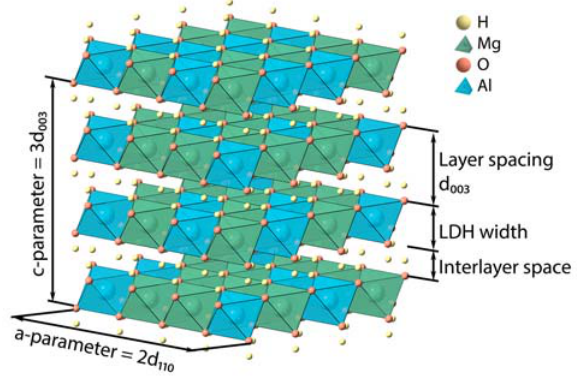
Figure 1. Schematic illustration of a MgAl-LDH.